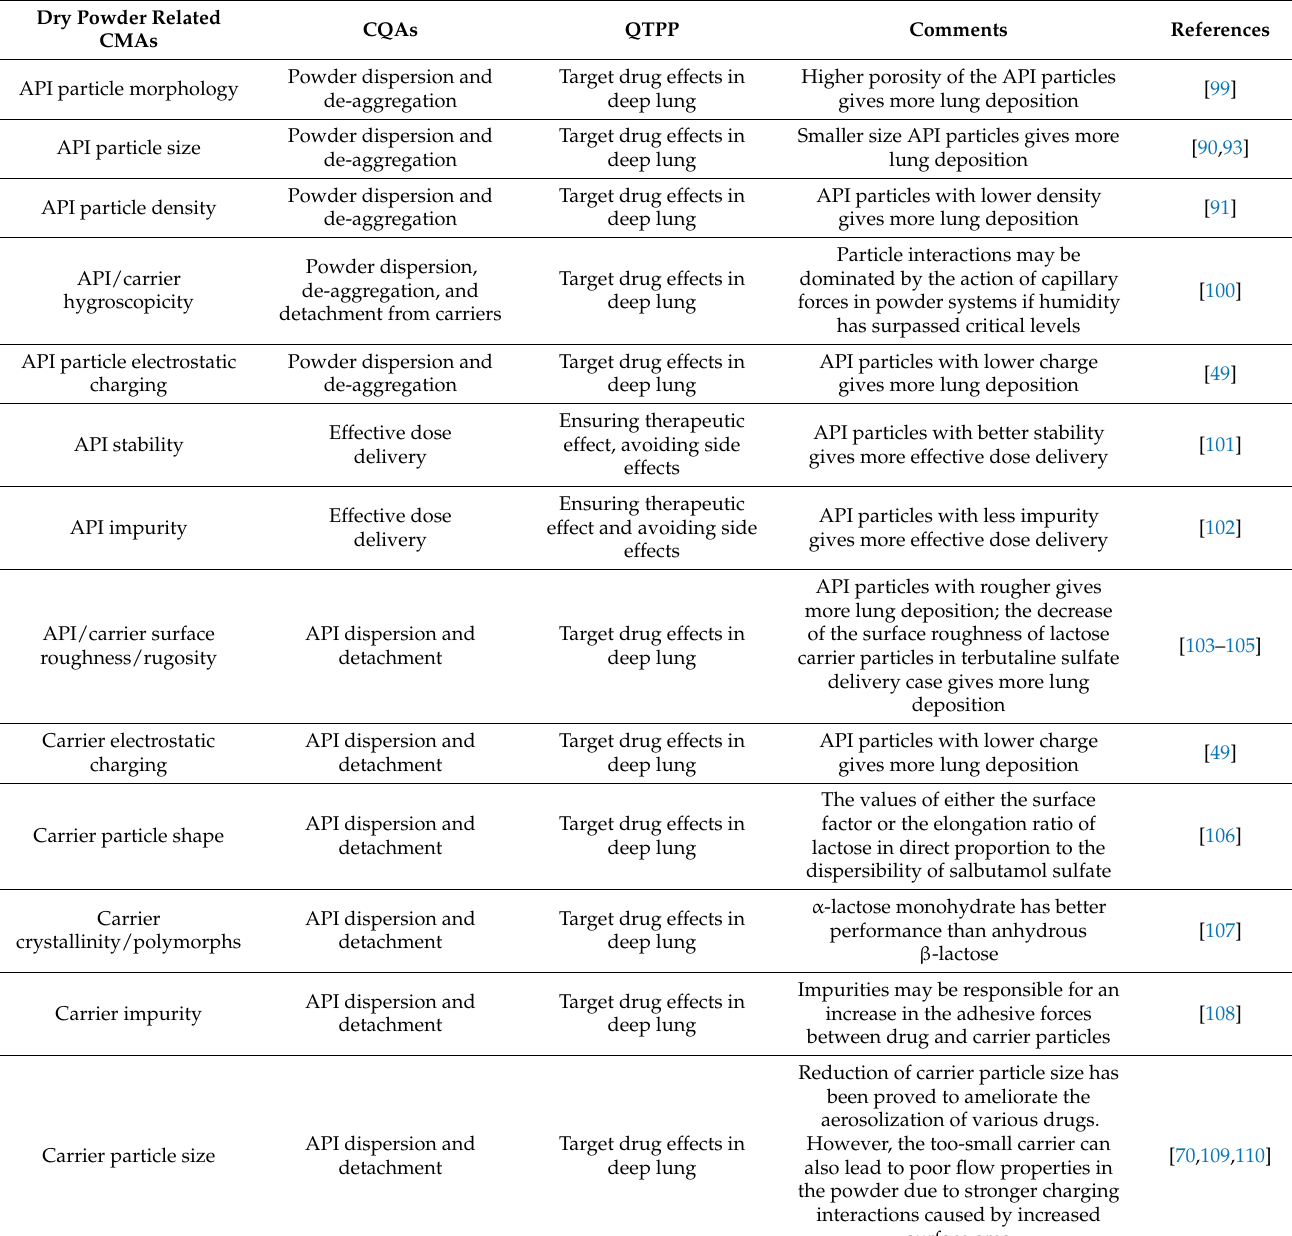
Table 3. Summary of dry powder-related CMAs and their influence on CQAs and QTPP of